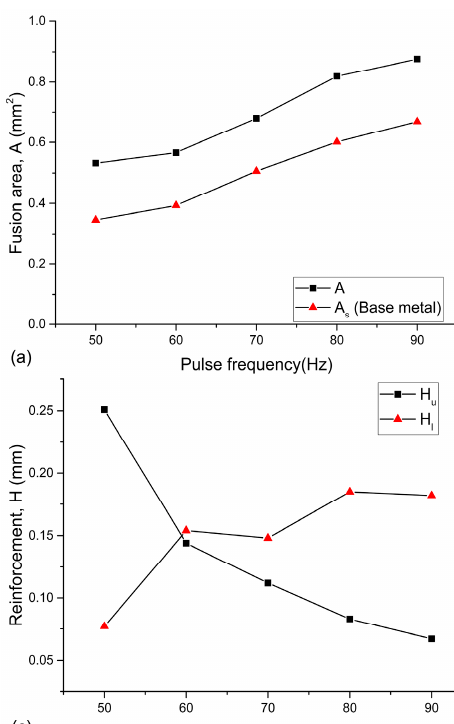
Figure 6. Variations of weld bead parameters with pulse duration: ( a ) fusion zone area; ( b ) weld width; ( c ) reinforcement height; ( d ) reinforcement height ‐ to ‐ width ratio.